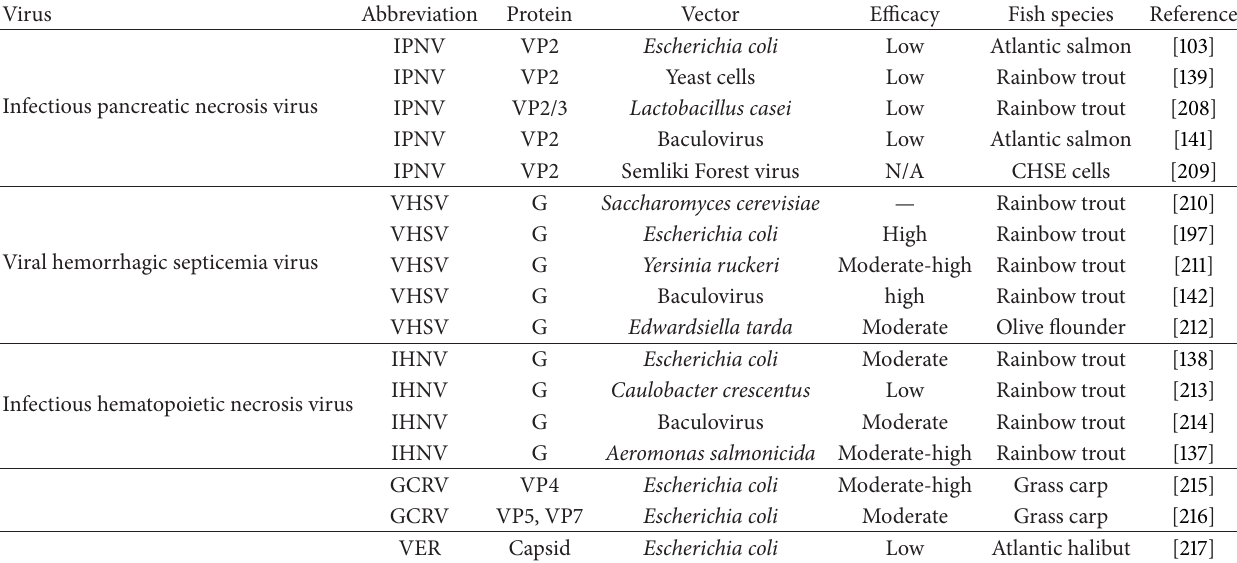
Table 6: Subunit